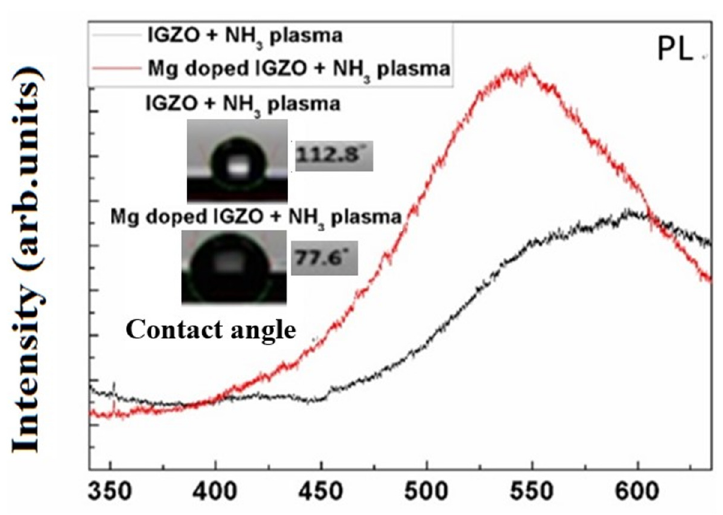
Figure 4. PL spectra and surface contact angle measurements for IGZO with NH 3 plasma treatment and Mg doped IGZO with NH 3 plasma treatment.